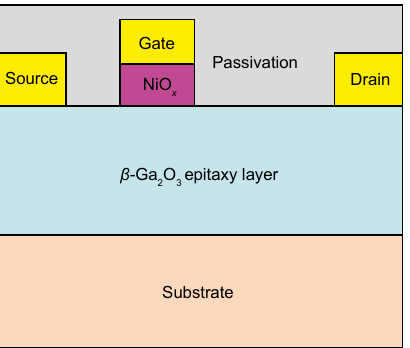
Figure 12. Device structure of the β ‐ Ga 2 O 3 FET with p ‐ NiOx gate dielectric.